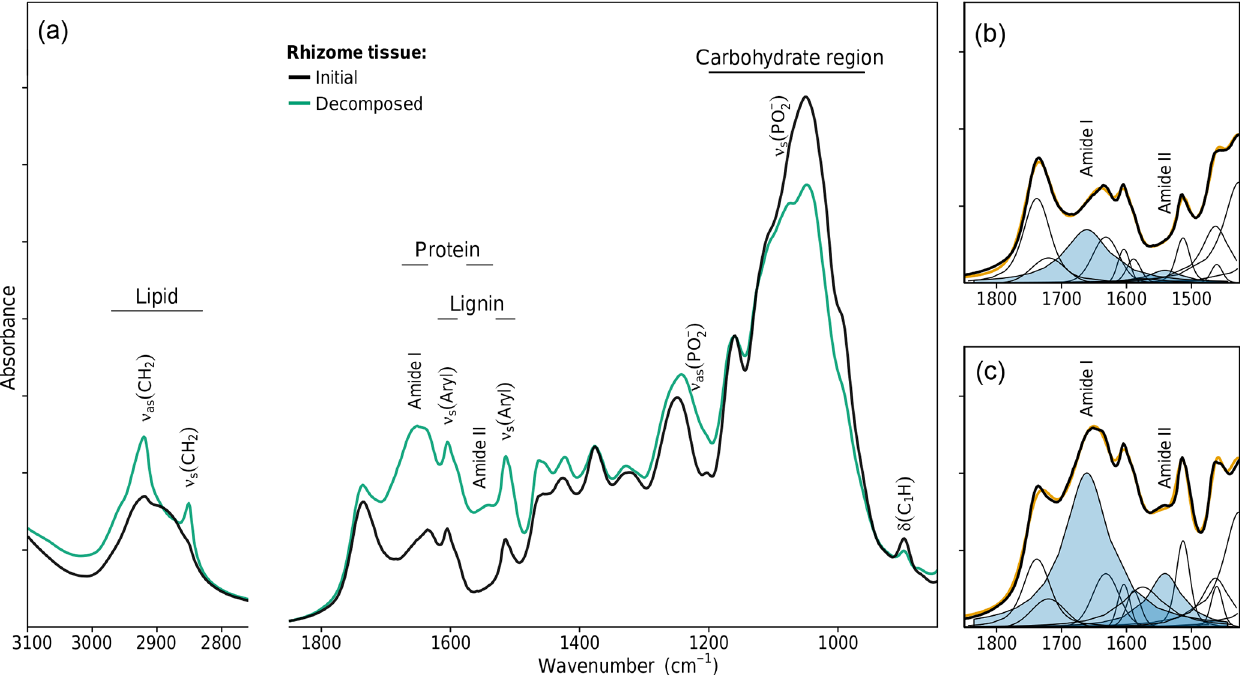
Figure 3. FTIR spectroscopic analysis of changes in rhizome tissue chemical composition after decomposition in the medium-N soil. (a) FTIR absorption spectra. (b, c) Peak fitting of the FTIR spectra of the initial and decomposed rhizomes. Plotted bands in blue denote the amide I and amide II bands of proteins.